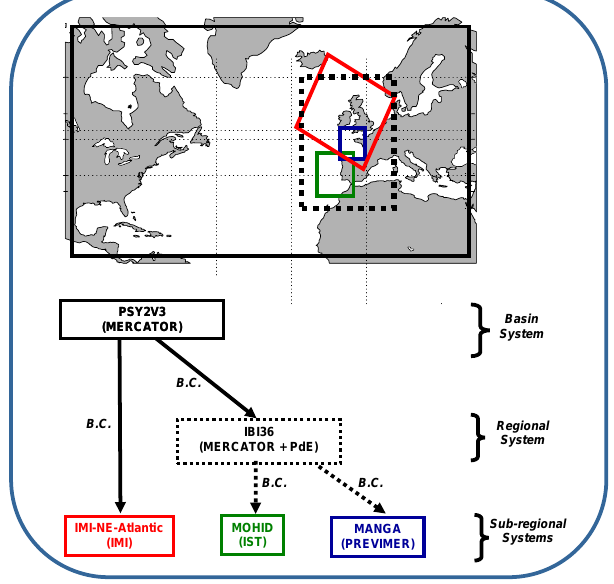
Figure 5 : Downscalling scheme planned for integrated IBIROOS V2 but still not operational for ECOOP (B.C. = Boundary Conditions)